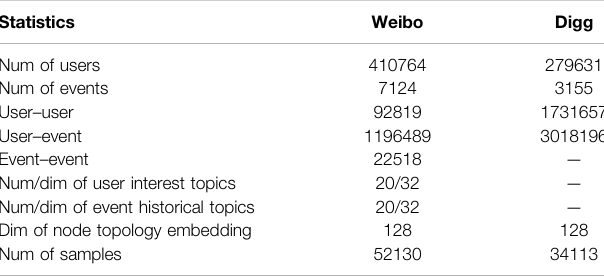
TABLE 1 | Statistics of the